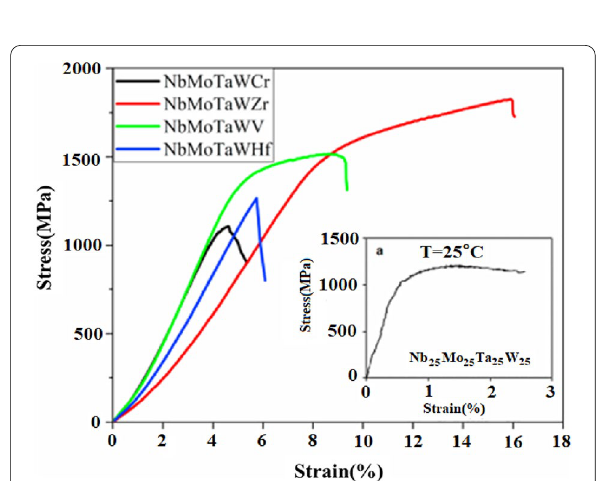
Figure 4 The engineering compressive stress-strain curves of NbMoTaW x ( x Cr, Zr, V and Hf) RHEAs [34] =